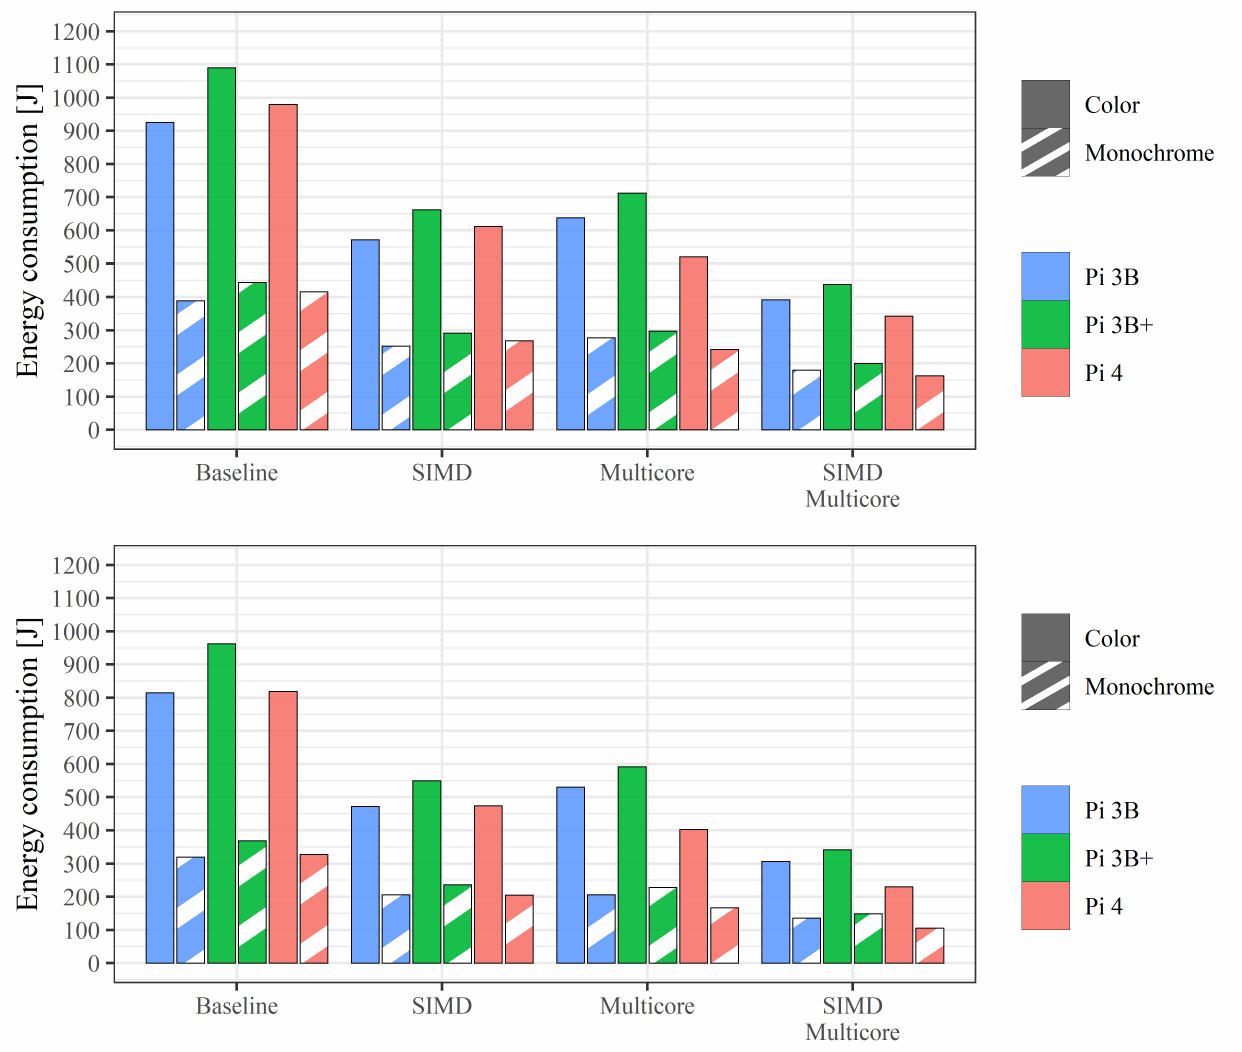
Figure 9. OTV algorithm: energy drained during a single run at ( Top ) full resolution and ( Bottom ) half